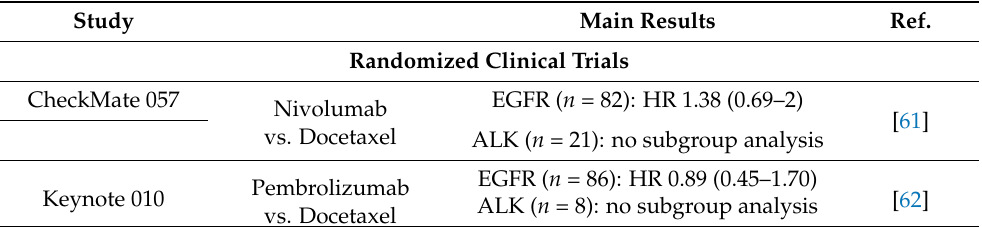
Table 4. Clinical data on anti-PD1 efficacy in NSCLC with actionable oncogenic driver alterations.